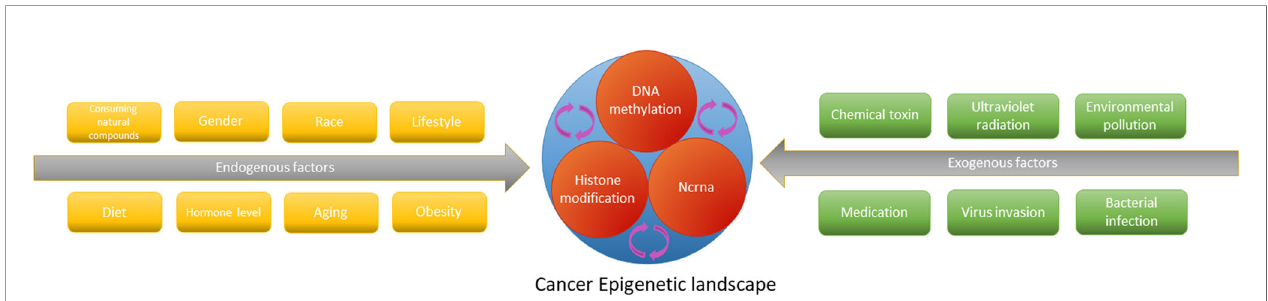
FIGURE 4 | The epigenetic cascade network mediated by endogenous and exogenous factors interferes with tumorigenesis and progression by affecting gene